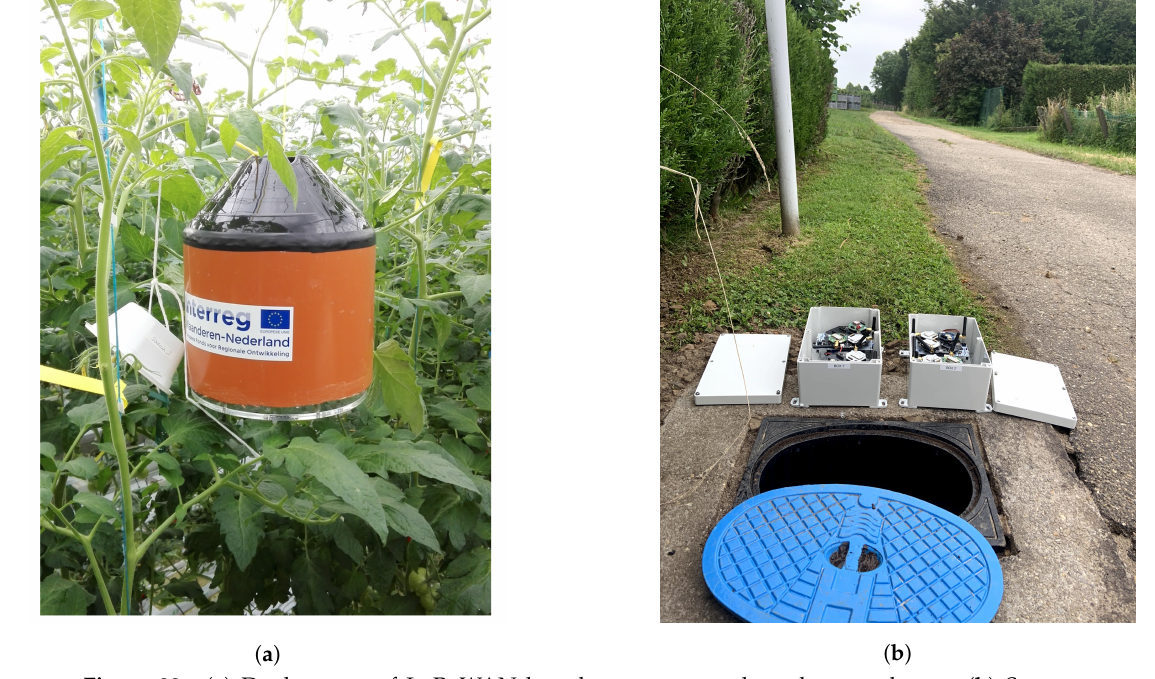
Figure 22. ( a ) Deployment of LoRaWAN based sensor network at the greenhouse; ( b ) Sensors deployment in remote locations i.e., underground water grid.